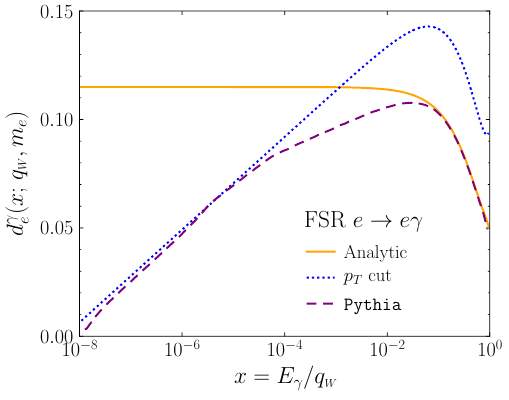
Figure 8 . A comparison of the electron FSR spectrum to various analytic calculations. In solid orange we show the expected analytic result from eq. (5.1), in dashed purple the corresponding result from Pythia , and in dotted blue the analytic spectrum in eq. (D.2) with a p cut deviation of Pythia from the expected analytic result to the p treatment of this